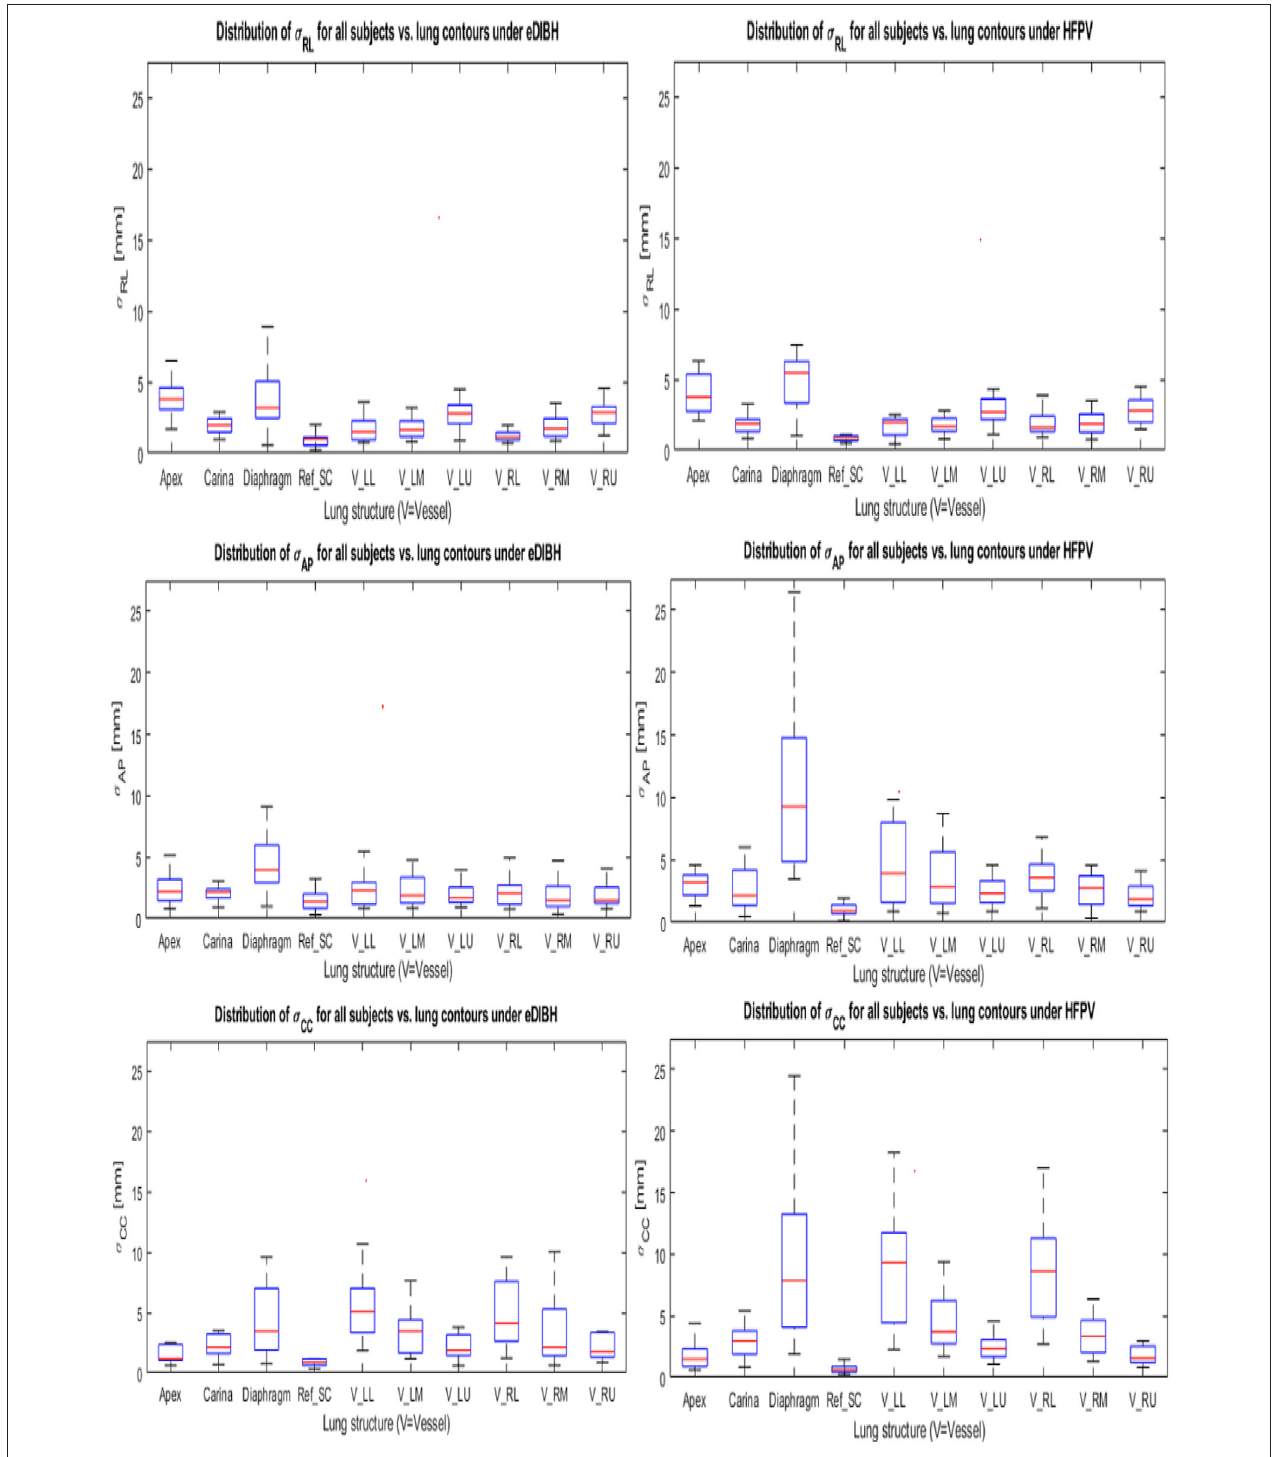
FIGURE 9 | Standard deviations about the mean positions of each LSC-specific cluster in Cartesian coordinates for eDIBH and HFPV (see Section Measuring Intra- and Interfractional Lung Displacements and Figure 3 ). The coordinates are labeled in table notation: RL (top row), AP (middle row), and CC (lower row).